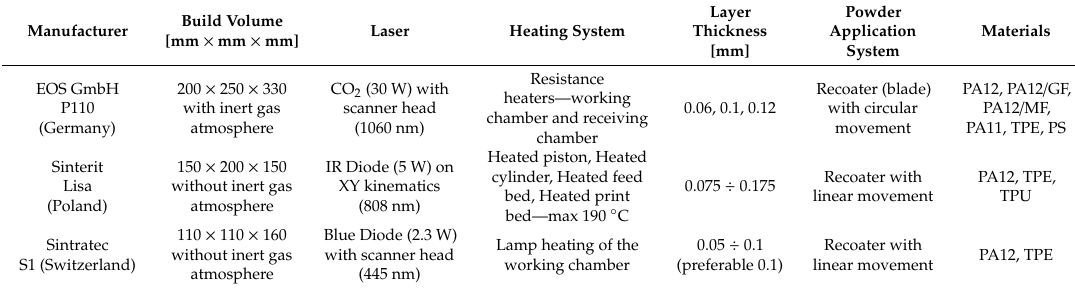
Table 1. Basic Hardware Data Regarding the Tested Laser Sintering (LS) Machines